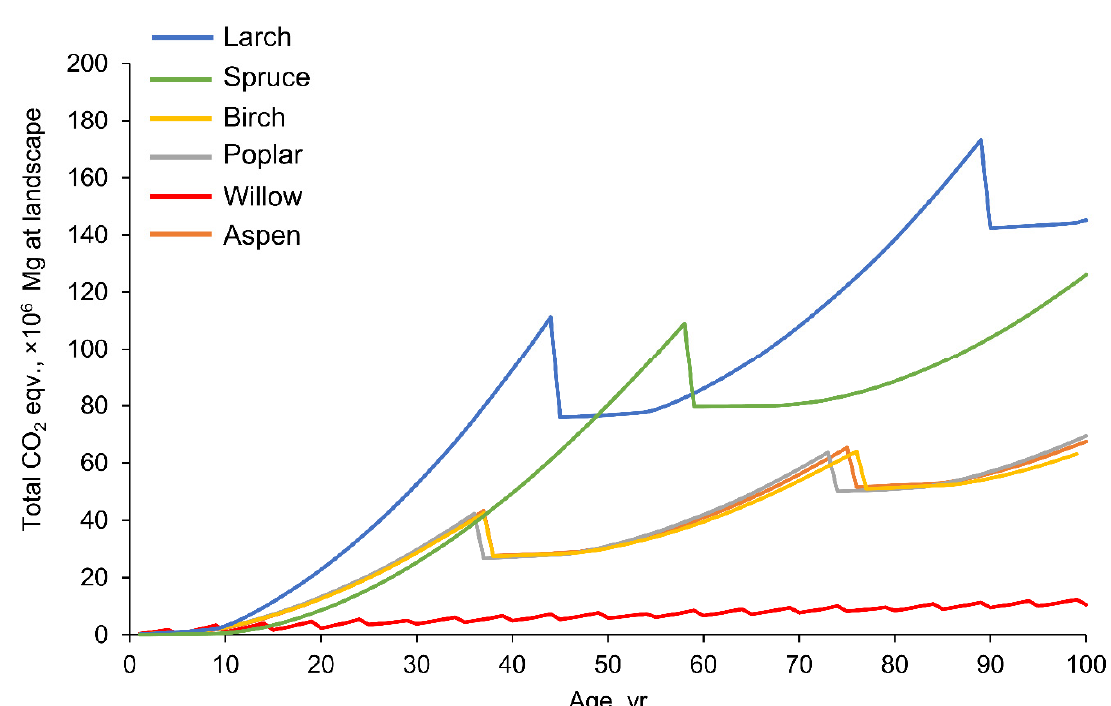
Figure 3. The development of the climate benefit at the landscape level according to the analyzed scenario expressed as the sum of removed CO 2 from the atmosphere due to increased carbon stocks and avoided CO 2 -emissions related to substitution effects over 100 years for the studied tree species.